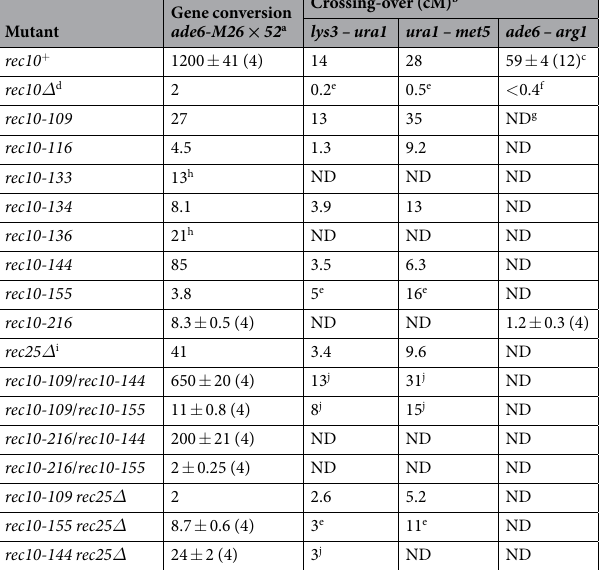
Table 2. Locus-specific reduction of meiotic recombination in rec10 mutants. a Ade + spores/million viable spores, as mean of two independent experiments or mean ± SEM of four independent experiments. > 200 total colonies and > 20 Ade + colonies were counted for each determination except for rec10 Δ , rec10-116, rec10- 109 / rec10-155 and rec10-109 rec25 Δ (less than 20 Ade + colonies were counted). b 120 spore colonies from each cross were tested for recombinants. Frequencies were converted to cM using Haldane’s equation. c Collective data for rec25 + , rec27 + and mug20 + (Supplementary Table S3). d rec10-175::kanMX6 . e From 11 ; wild-type